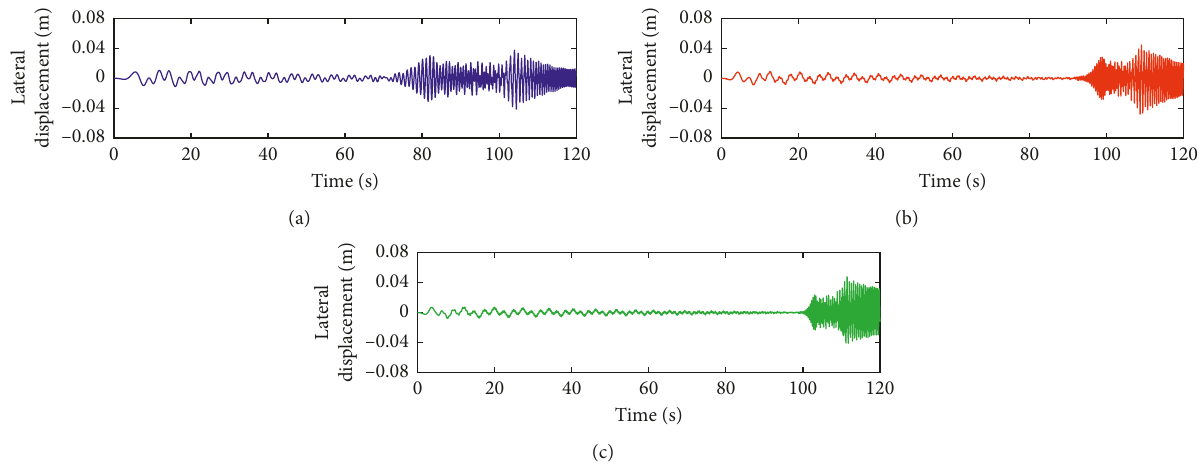
Figure 5: Lateral vibration displacements at l ( t ) /2 of the vertical rope in lifting. (a) The first-order excitation, (b) the second-order v excitation, and (c) the third-order excitation of head sheave axial wobbles.